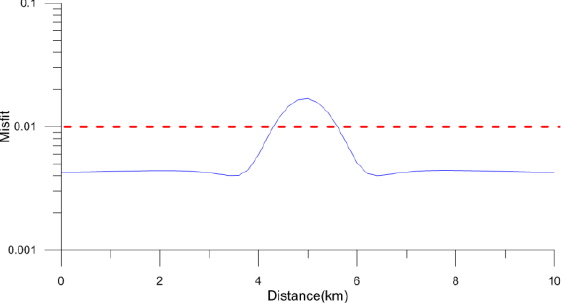
Figure 7. The misfit curve of a single station. The red dotted line is the threshold value of 0.01.